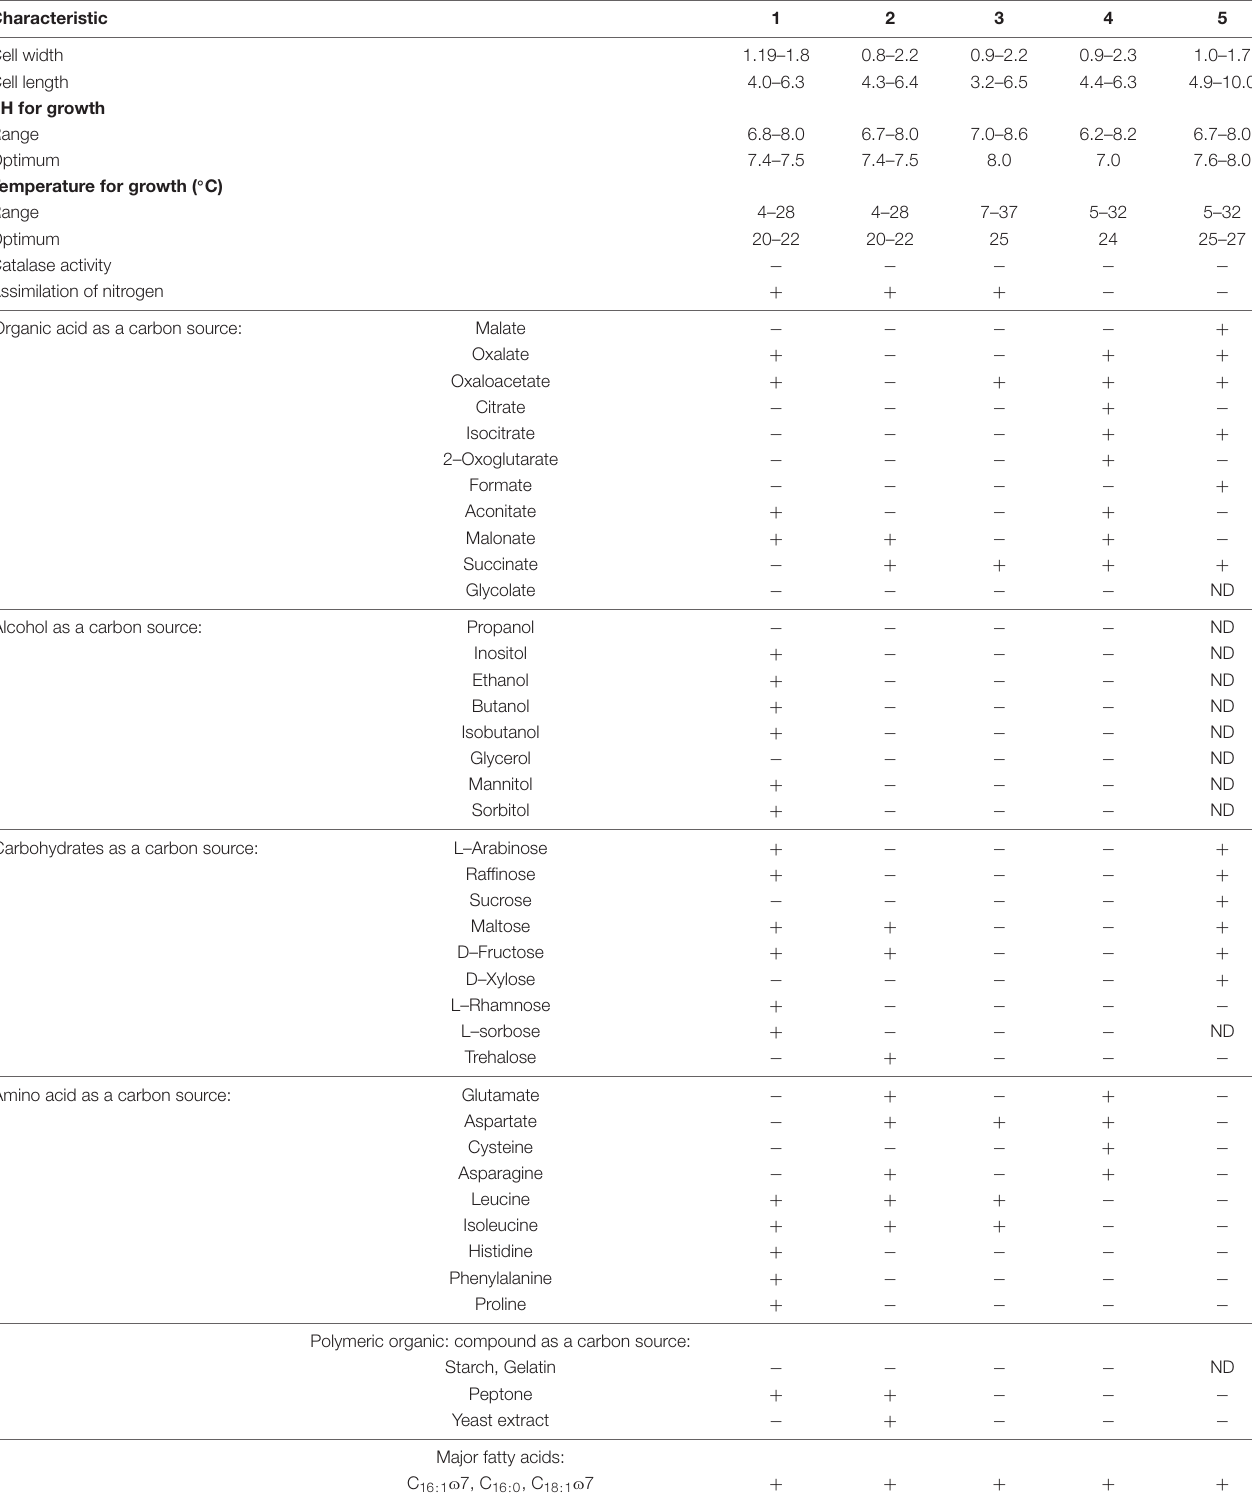
TABLE 3 | Comparison of phenotypic and physiological properties of Thiothrix